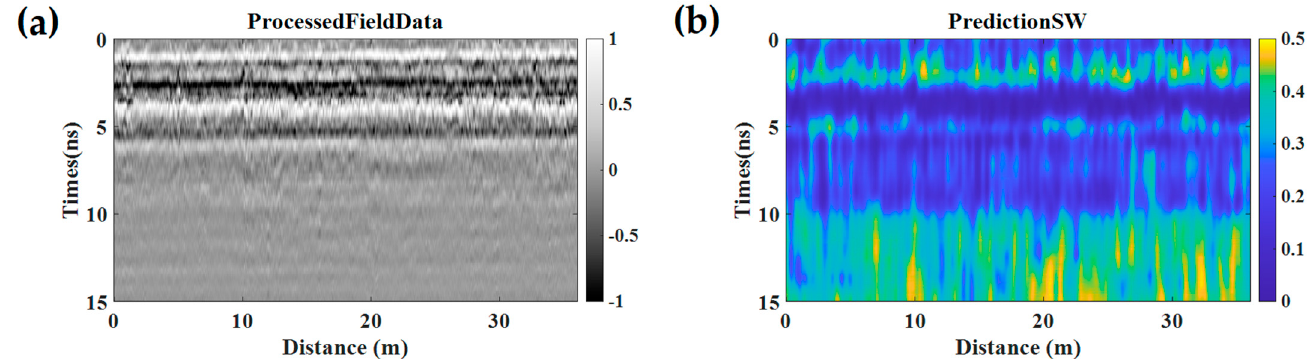
Figure 8. ( a ) Processed GPR data under line 1; ( b ) VSWC predicted value under line 1.